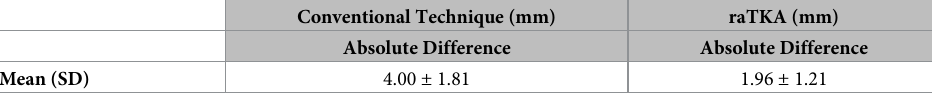
Table 2. Absolute difference values in change in joint line height between techniques.